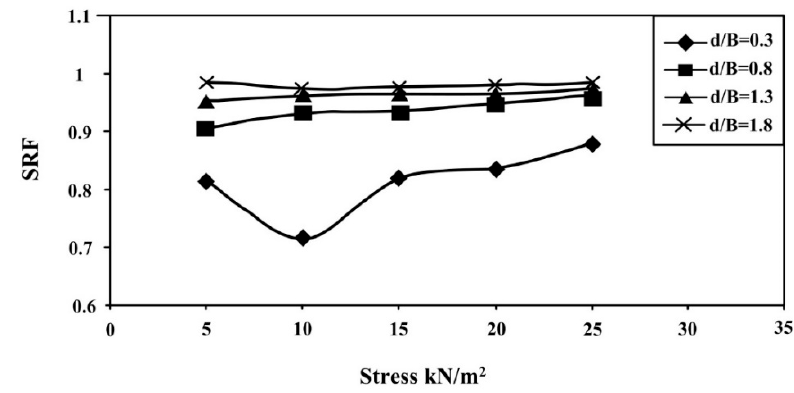
Table 5. Typical and recommended parameters of the soft soil reinforcement system. Figure 14. Settlement reduction factor variation against stress (modified from Sridhar and Prathapkumar [37]).